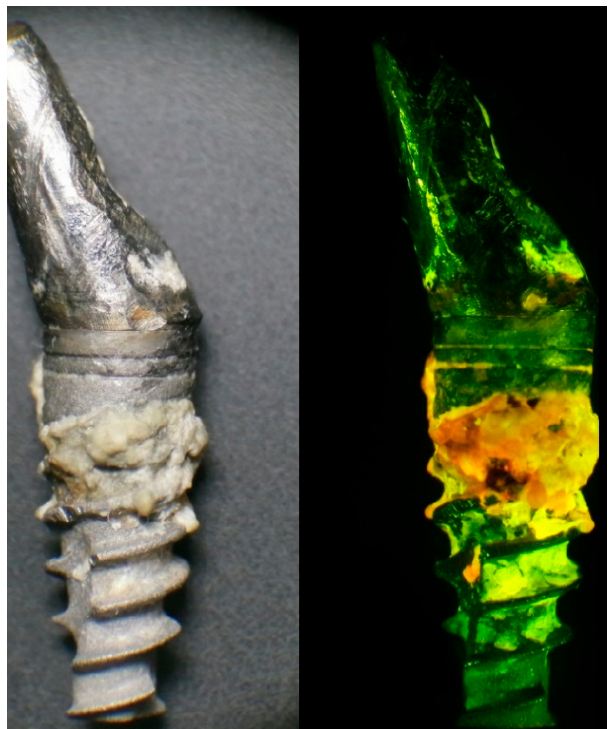
Figure 1. A failed implant after its removal due to peri-implantitis with significant plaque accumu- lation under natural light ( left ). Under UV headlight and special-filter loupes, plaque and active bacteria become visible in orange and red fluorescence ( right ). This may enable a proper differential diagnosis of peri-implant disease and facilitates accurate plaque removal.